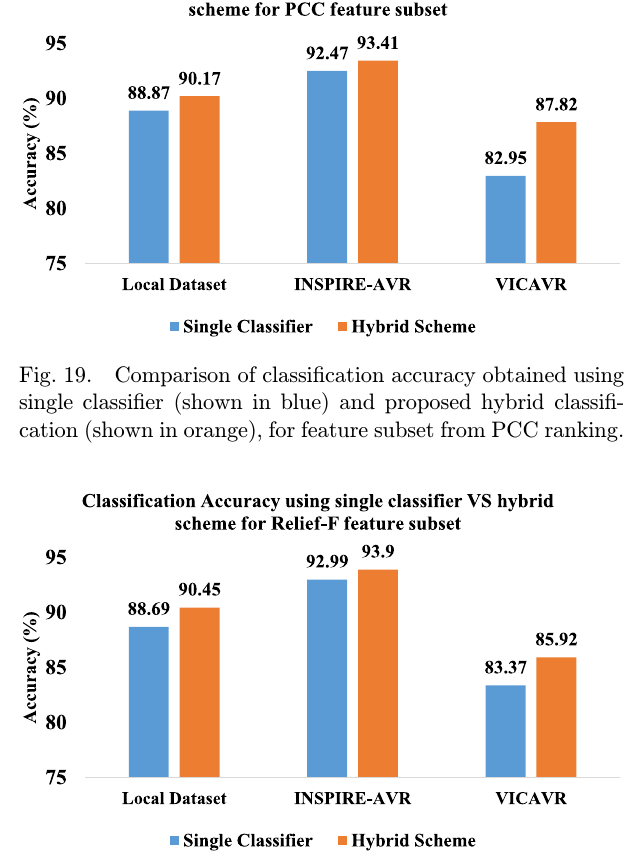
Fig. 20. Comparison of classi¯cation accuracy obtained using single classi¯er (shown in blue) and proposed hybrid classi¯- cation (shown in orange), for feature subset from Relief-F ranking.